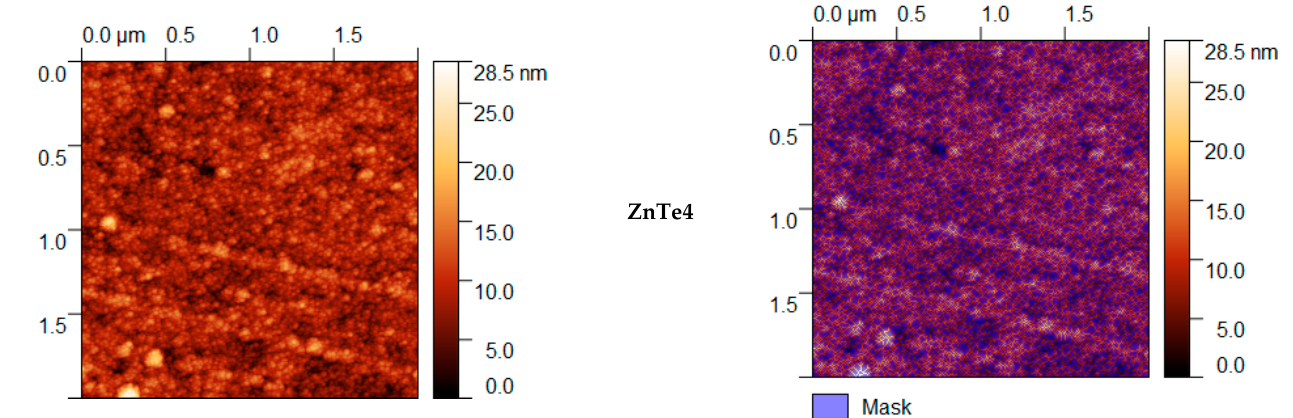
Figure 3. AFM characterization of ZnTe thin films with different thicknesses. The calculated majoritarian specific parameter size grains are presented in Table 1.